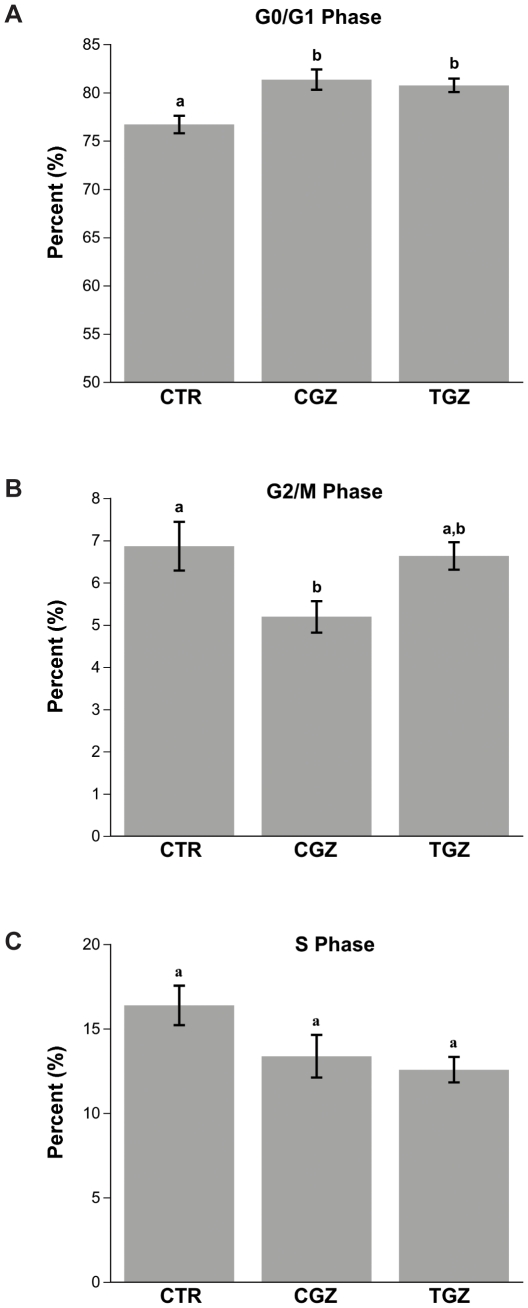
Cell cycle kinetics using flow cytometry.Ovcar3 cells were serum starved for 24 hours and treated for an additional 24 hours with vehicle control (DMSO) or 10 µM of CGZ or TGZ. (A) G0/G1, (B) G2, (C) S phase. Results are the means ± SEM for at least 3 measurements from three individual experiments. Bars that do not share a letter or number designation are significantly different (p<0.05).